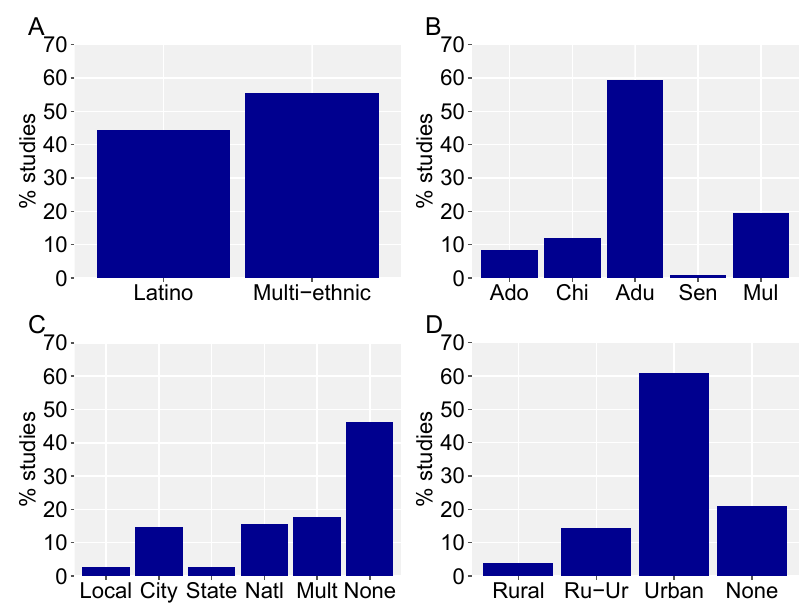
Figure 2. Comparative percentages of studies that focused solely on ( A ) Latino populations versus multiethnic comparisons; ( B ) Adolescents, Children, Adults, Seniors, or Multiple (referring to two groups or no specific age group); ( C ) park type in those cases when parks were a focus of the study (55% of all studies); and ( D ) urbanization of the research setting.